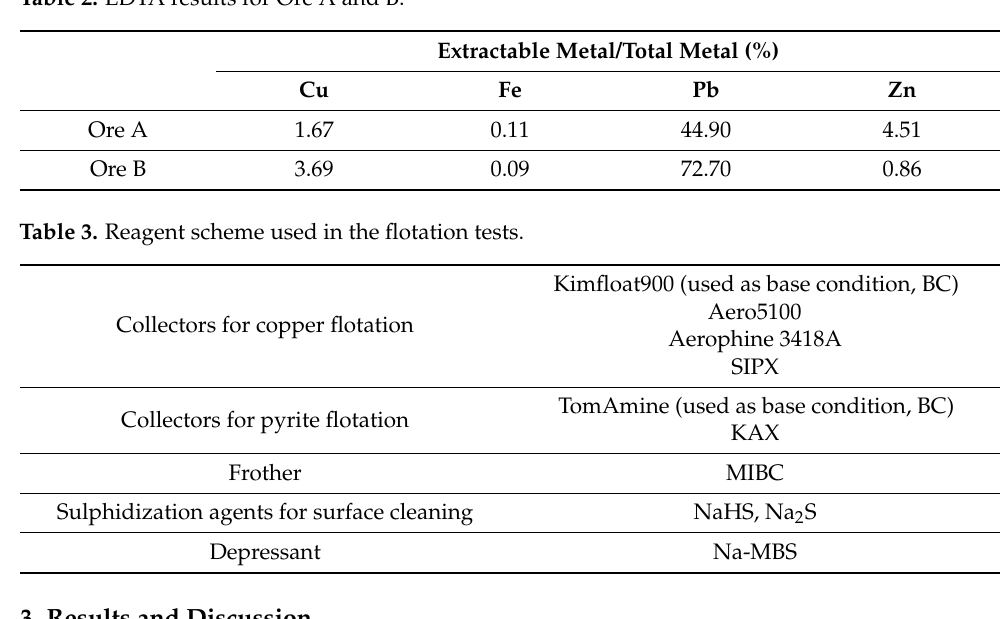
Table 2. EDTA results for Ore A and B.